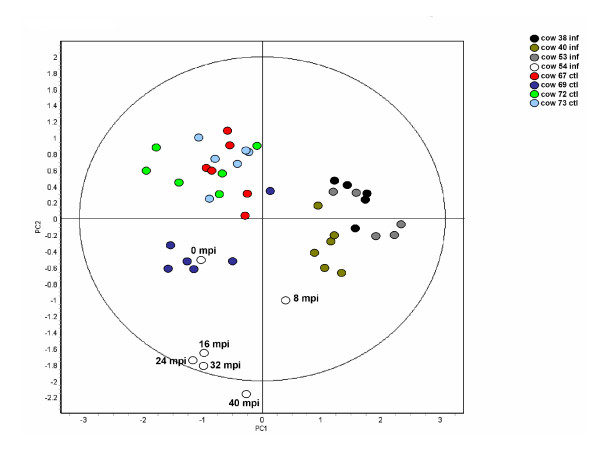
Principle component analysis of the 8 biological replicates. The samples obtained from individual infected and control cows clustered together indicating that disease is the factor that most influences the differential abundance observed in the urine samples. The time of the 6 sample collections from cow #54 are given to illustrate that the urine proteome of this animal diverged further from all the other animals as the disease progressed. This analysis was based on the 36 spot features exhibiting statistically significant (ANOVA p < 0.01) changes in abundance and present on all 46 gel images. (PC1 = 36.3, PC2 = 15.2).